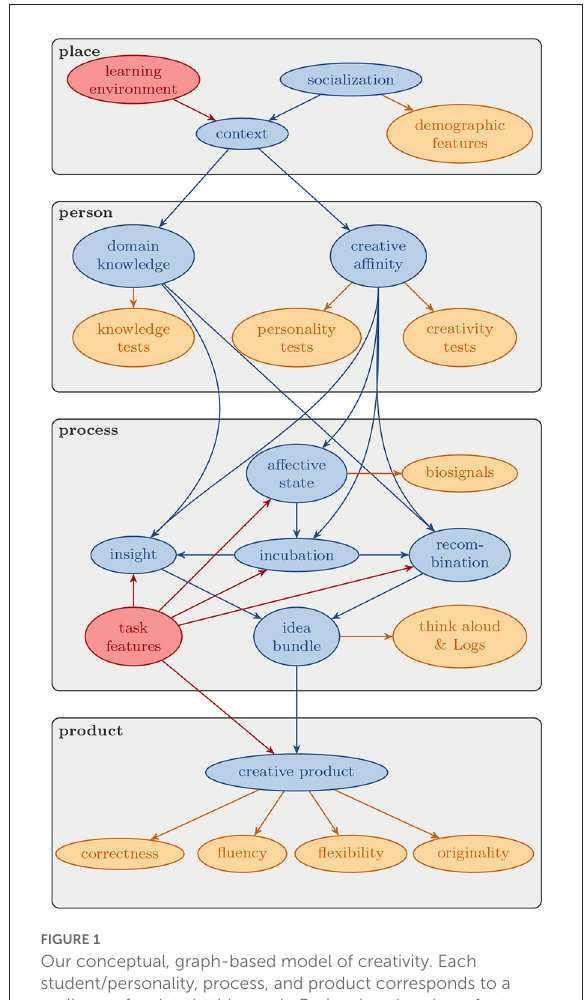
FIGURE1 Our conceptual, graph-based model of creativity. Each student/personality, process, and product corresponds to a replicate of a plate in this graph. Red-colored nodes refer to interventional variables, orange nodes to observable variables, and blue nodes to hidden